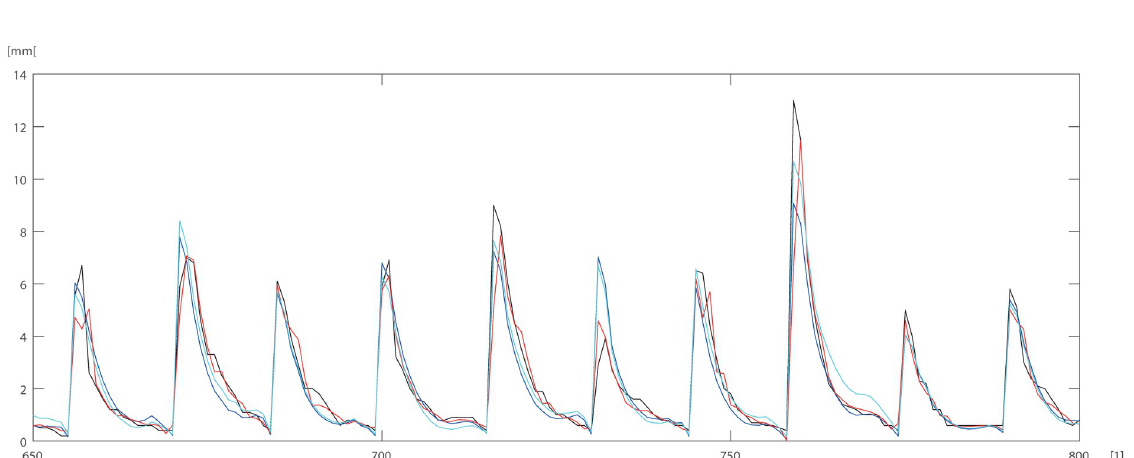
Fig 9. 400 DBT data (black line), STAT 2 (blue line), STAT 1 (cyan line), ANN (red line) for oak. Horizontal axis [1]—identifier of measurement.